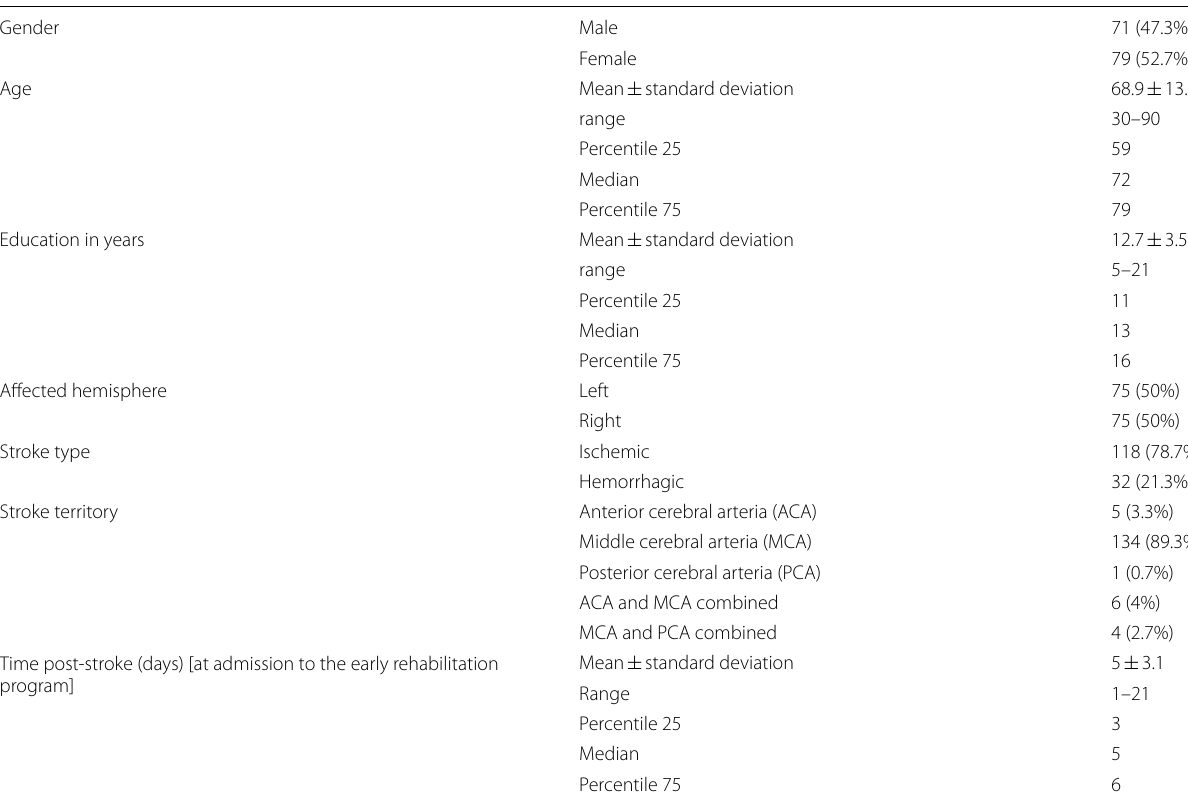
Table 1 Demographic and clinical information of the current stroke patients sample (n